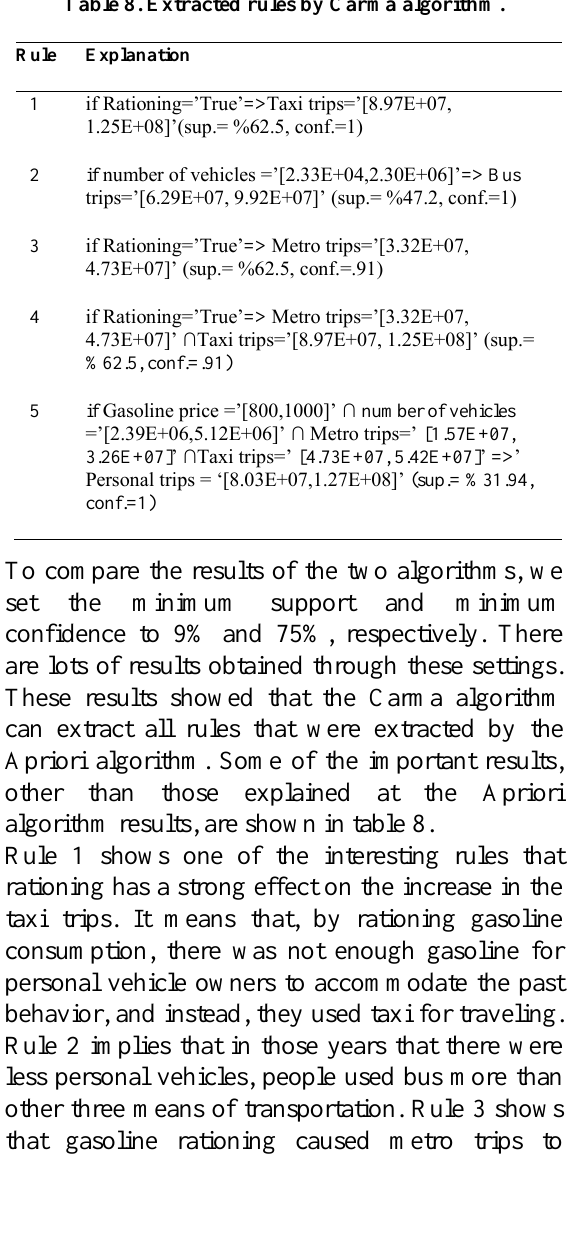
Table 8. Extracted rules by Carma